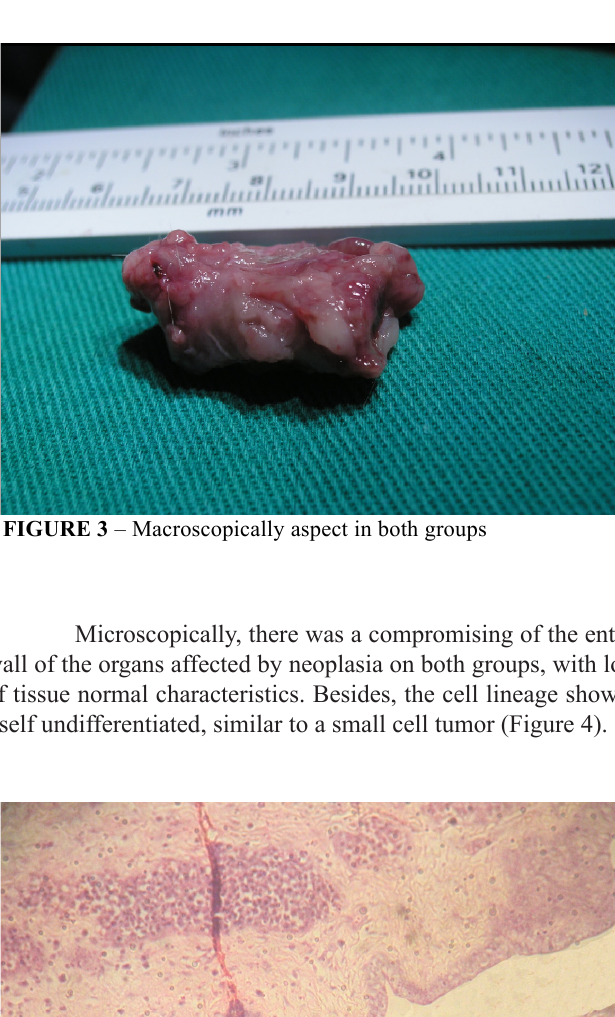
Source: research